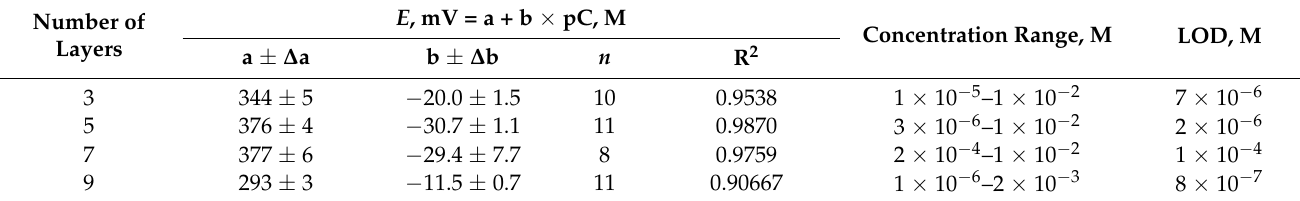
Table 1. Analytical characteristics of Cu 2+ determination with potentiometric sensor based on GCE covered with polyaniline and P[6]A–Cu 2+ layers. Average results from individual sensors, measurements in triplicate in 0.1 M